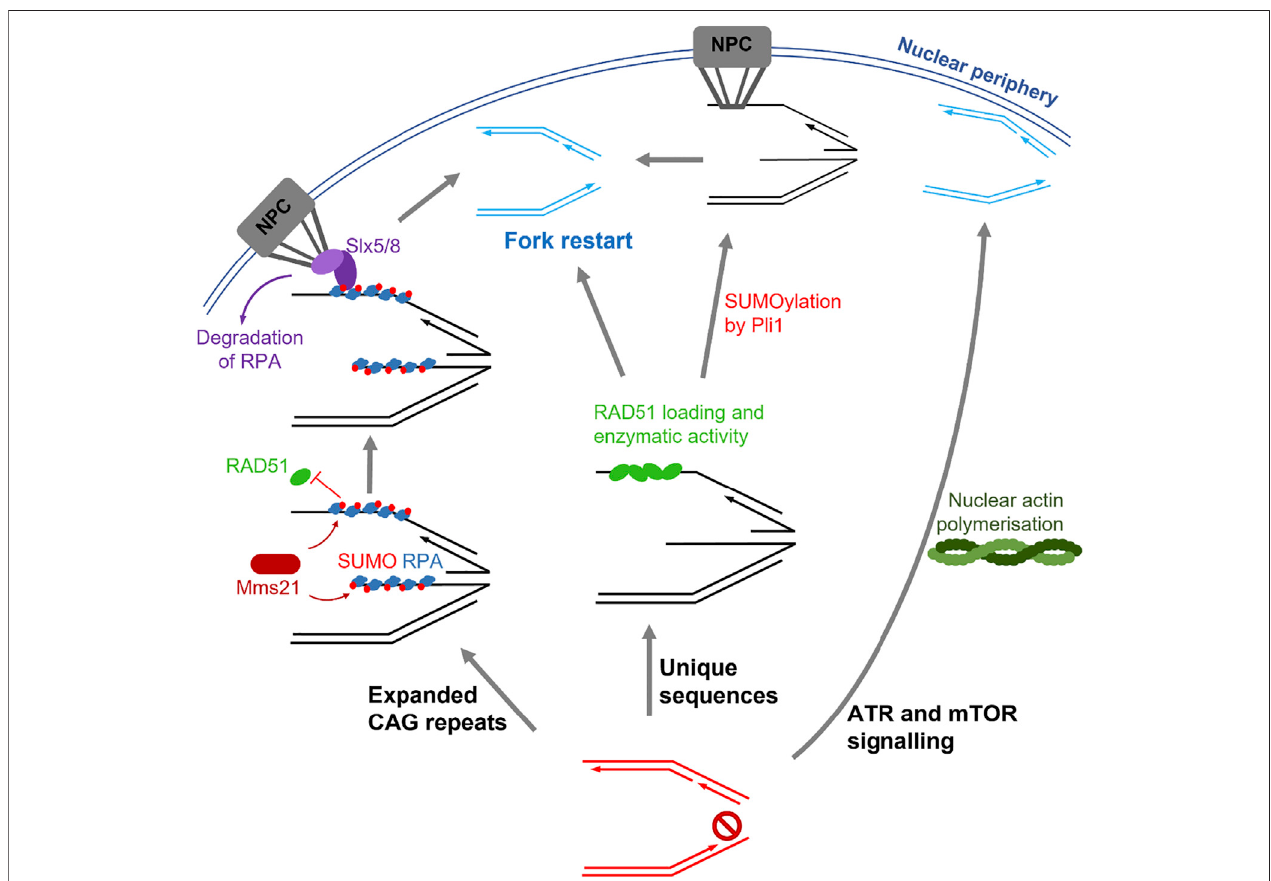
FIGURE 2 | Summary of the pathways involved in stressed fork mobility. Left: fork stalling induced by expanded CAG repeats leads to SUMOylation of repair proteins such as RPA by Mms21, which block RAD51 binding. Tethering of the fork to the nuclear pore complex (NPC) by Slx5/8 binding releases this inhibition and allows fork restart. Centre: Replication fork stalling within unique sequences results in loading of RAD51 in the nucleoplasm followed by SUMOylation events by Pli1, which allow NPC tethering and fork restart. Alternatively, fork restart can also occur in the absence of SUMOylation and NPC tethering. Right: ATR and mTOR signalling during replication stress leads to polymerisation of nuclear actin. Stalled forks then move along the actin fi laments to the nuclear periphery, where fork restart can occur.